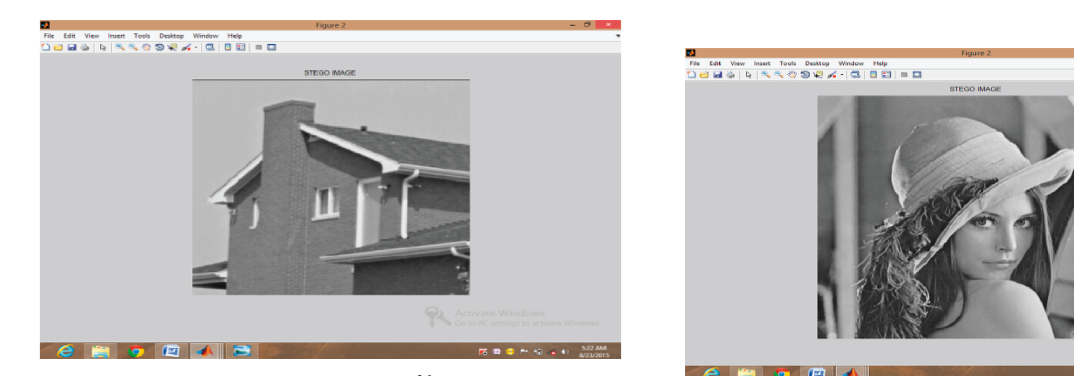
Figure 16: Stego image of house.